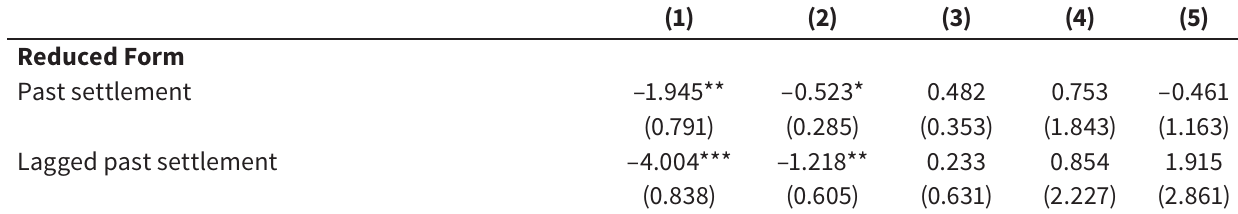
Reduced form and first stage results, 2000–2015 (multiple